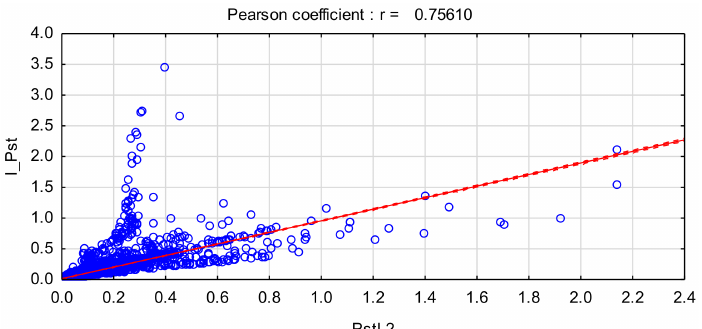
Figure 3. Spread chart for the flicker indicator and the short-term flicker severity for phase L2 in LV_H&E.